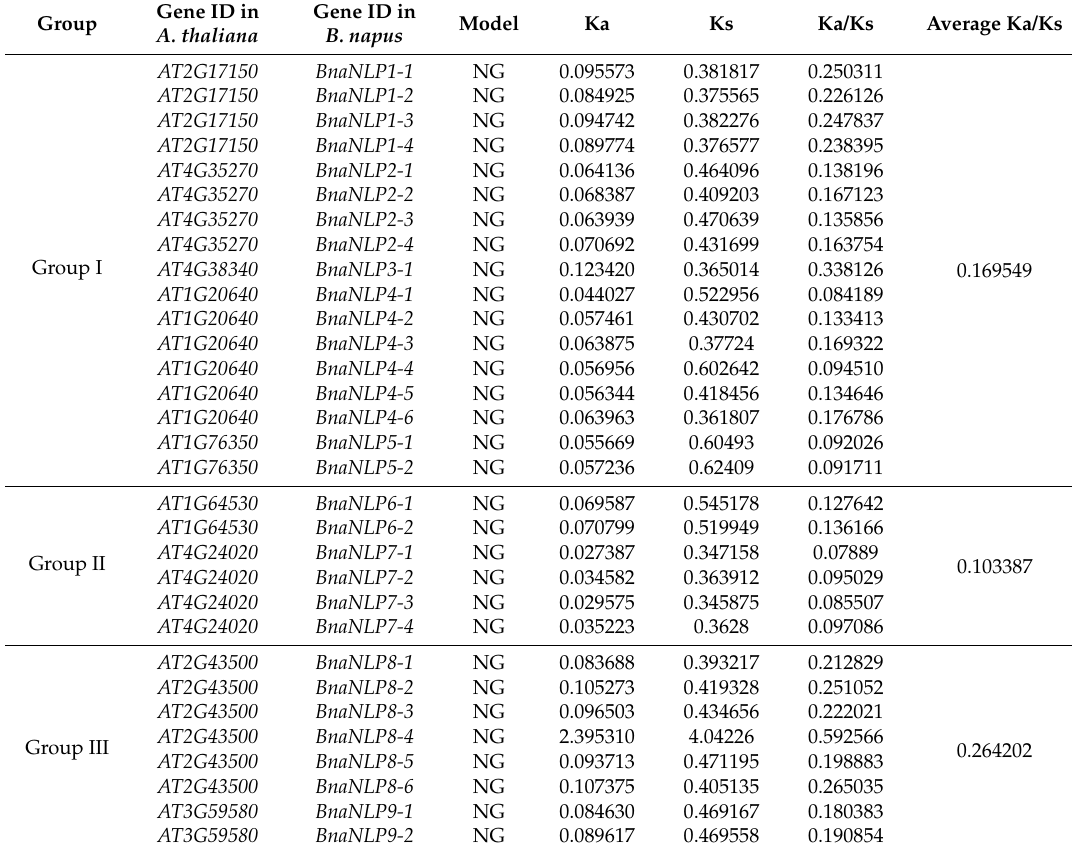
Table 2. Non-synonymous and synonymous nucleotide substitution rates between AtNLPs and the corresponding orthologs in B. napus